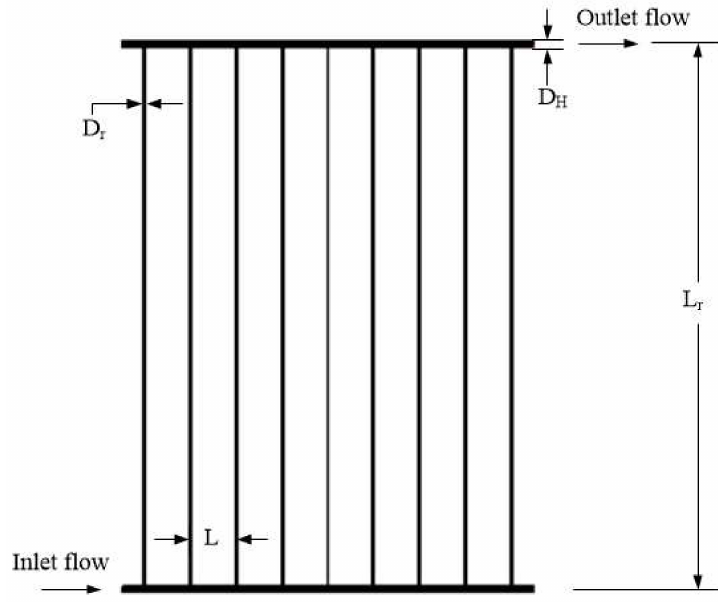
Figure 6. Sketch of the flat plate solar collector with nine riser tubes